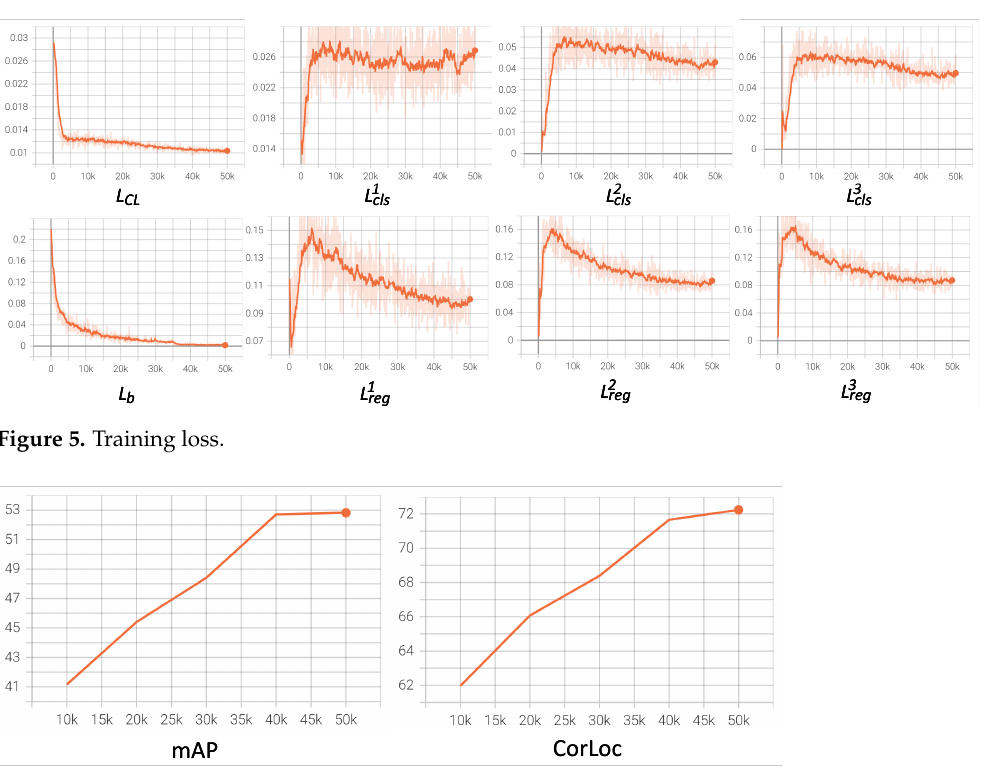
Figure 6. Model performance during the training process. Evaluations are performed every 10K without data